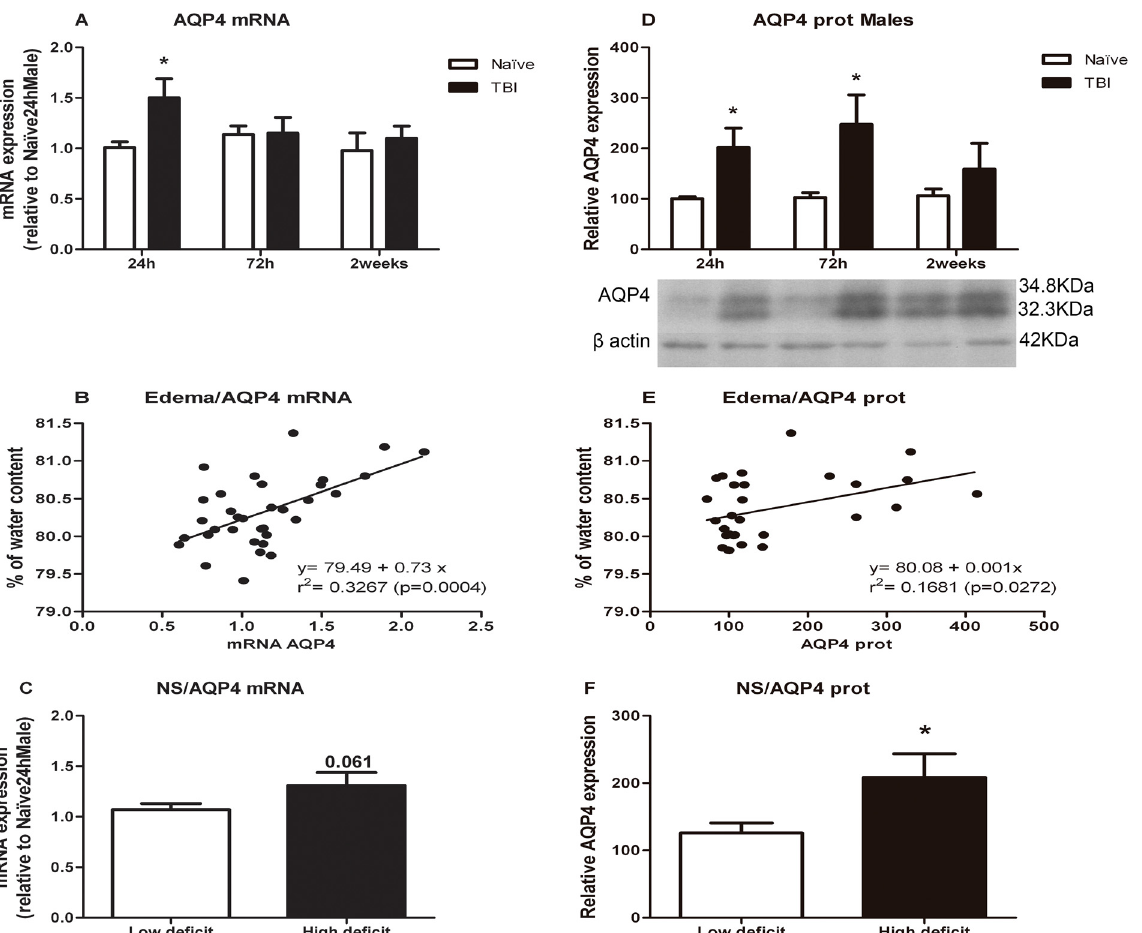
Fig 4. Effects of TBI on AQP4 mRNA and protein levels. A) AQP4 mRNA levels. B) Analysis of correlation between brain edema and AQP4 mRNA levels. C) AQP4 mRNA levels in animals classified according to neurological score. D) AQP4 protein levels. E) Analysis of correlation between brain edema and AQP4 protein levels. F) AQP4 protein levels in animals classified according to neurological score. Data are mean ± SEM. * p < 0.05 versus na ï ve group of same